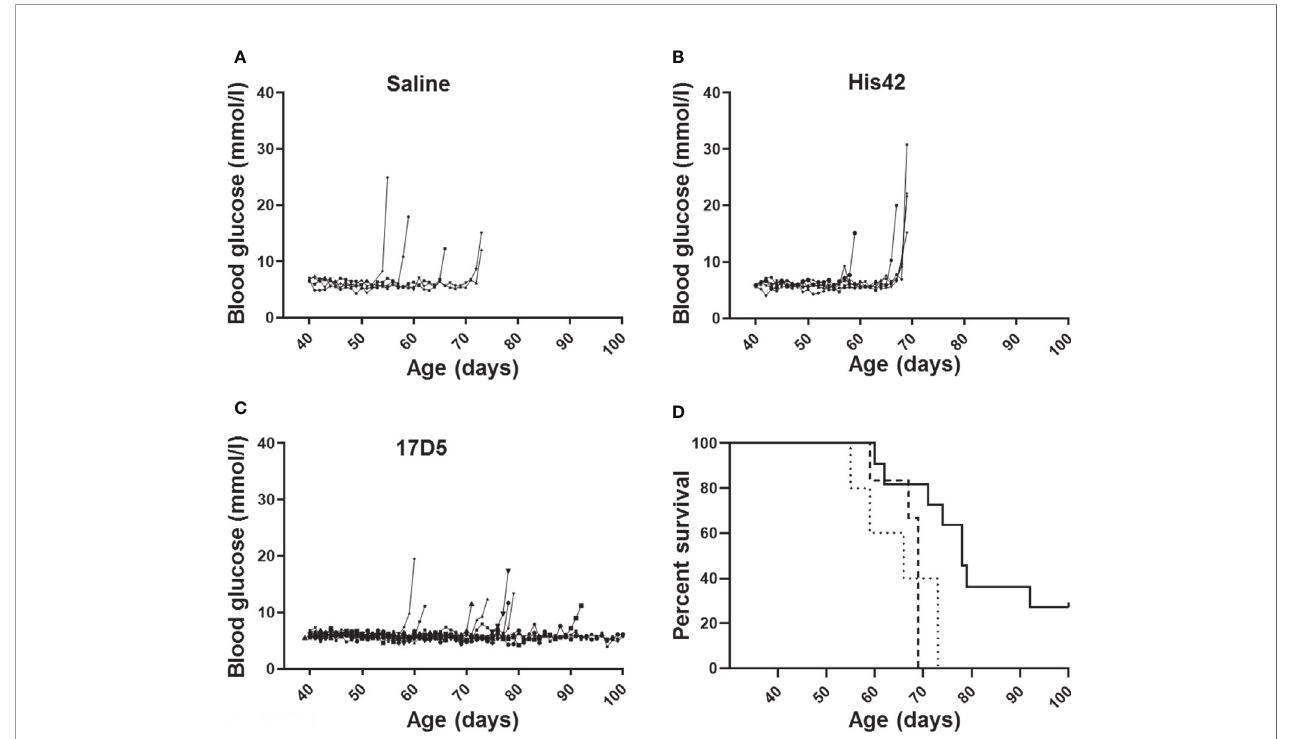
FIGURE 1 | Daily blood glucose levels measured daily and age at diagnosis of diabetes in DR Lyp/Lyp rats receiving either saline ( A , n = 5), monoclonal antibody His42 ( B , n = 6), or monoclonal antibody 17D5 ( C , n = 11). The saline treated DR Lyp/Lyp rats developed diabetes between 55 and 73 days of age (median 66 days). The His42-treated rats developed hyperglycemia between 59 and 69 days of age (median 69 days). In contrast, diabetes occurred in fewer rats treated with 17D5 (n = 8/11), between 74 and 92 days of age (median 76 days). Kaplan Meier analysis in (D) showed that survival times in the saline (dotted line) and His42 (dashed line) groups were statistically similar whereas survival in the 17D5 group (solid line) was prolonged ( P <